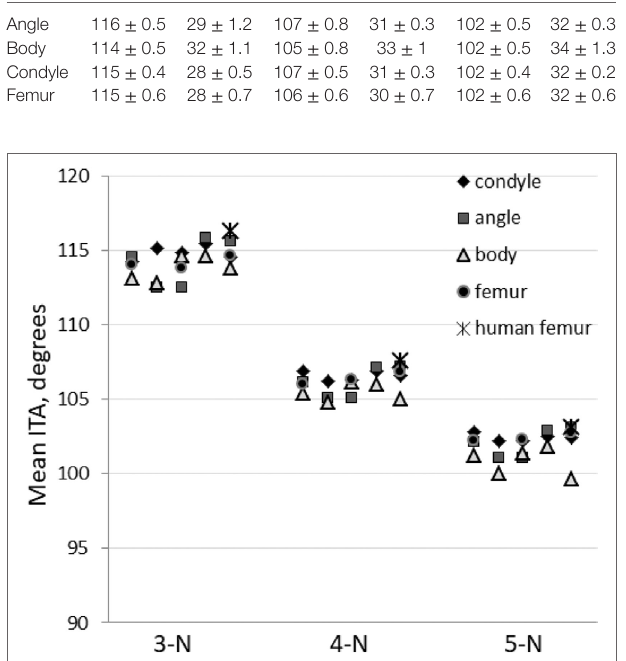
FigUre 7 | Inter-trabecular angle mean values for the three most abundant node types. All measurements are presented: five values of porcine mandibular condyle, angle and body and three values for porcine proximal femur. Human proximal femur values are averaged (five individuals) and shown for reference (Reznikov et al.,